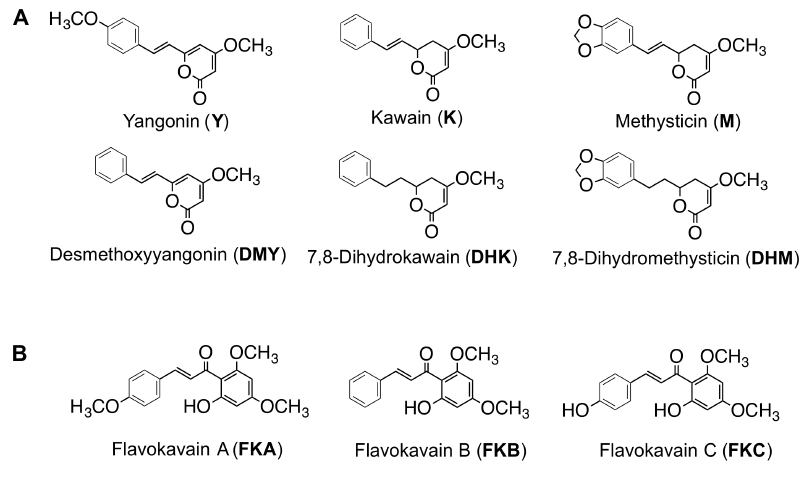
Figure 1. Chemical structures of ( A ) six major kavalactones and ( B ) three flavokavains.